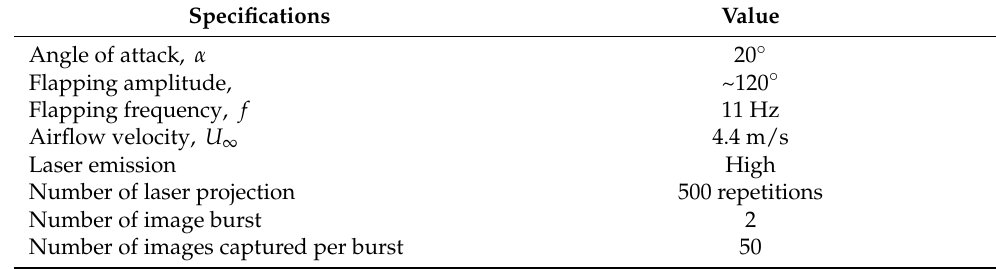
Table 3. Experimental setup and specifications.